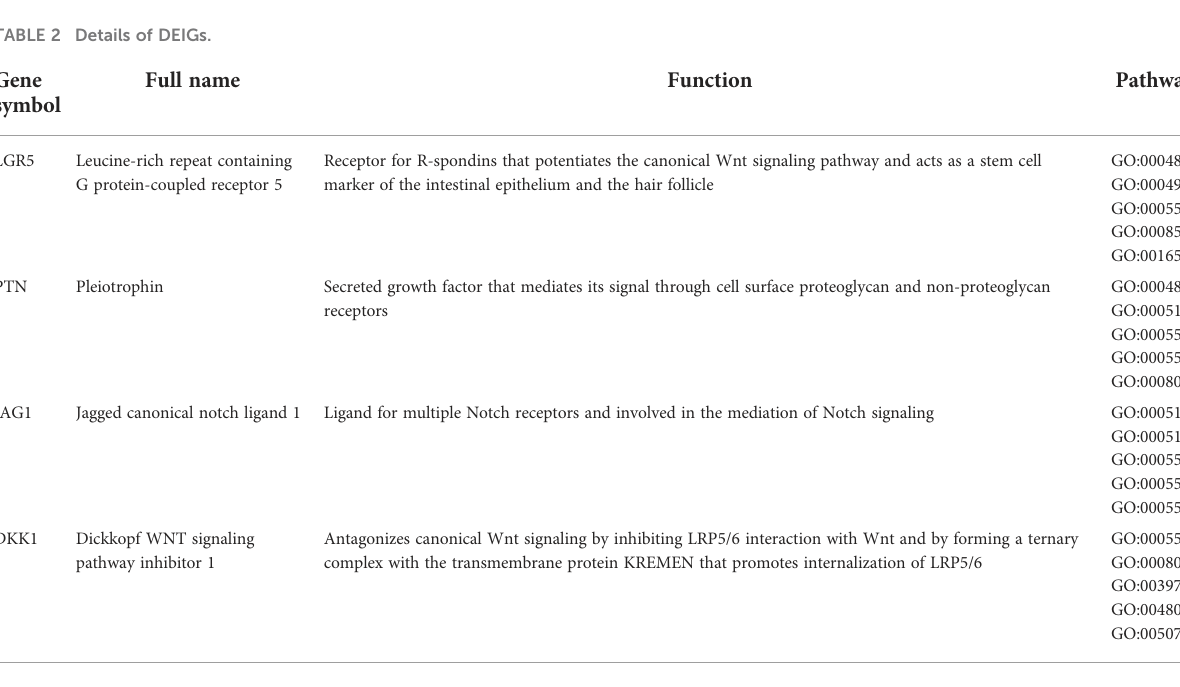
TABLE 2 Details of